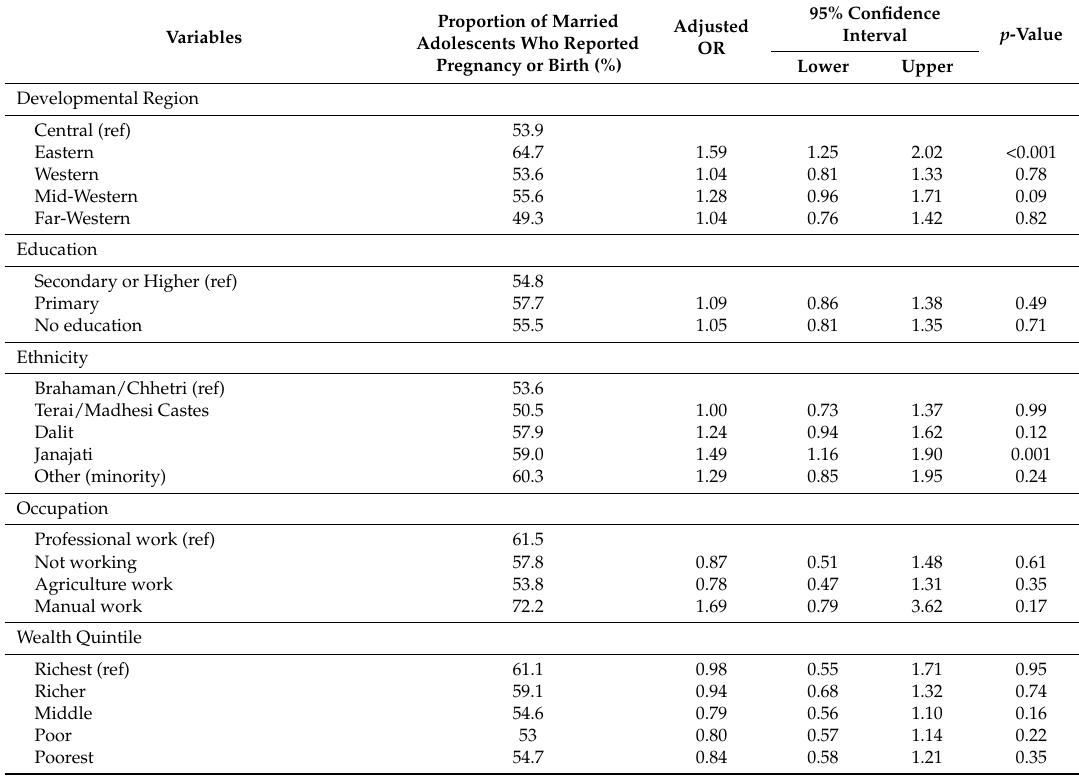
Table 3. Logistic regression of factors associated with pregnancy among married adolescent women. Variables